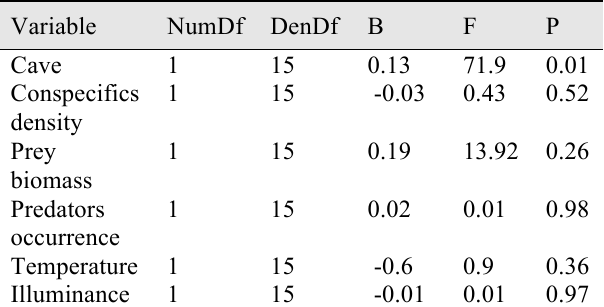
Table 2. Results of the Linear Models analysis of the relationship between fire salamander larvae, mortality rate and the environmental features in 21 spring and cave sites.